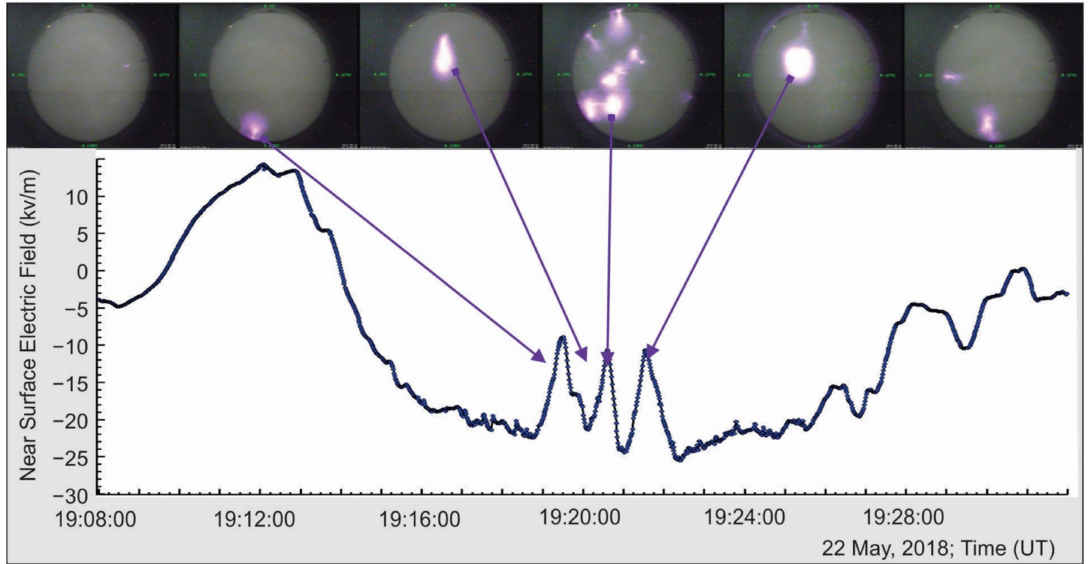
Figure 6. The disturbances of the NSEF during TGE, measured by an EFM 100 electric mill located on the roof of MAKET experimental hall (blue curve). In the upper panel, we demonstrate the 1 min time series of the panoramic camera shots of the sky above the station, with a violet arrow we indicate the times when panoramic shots were